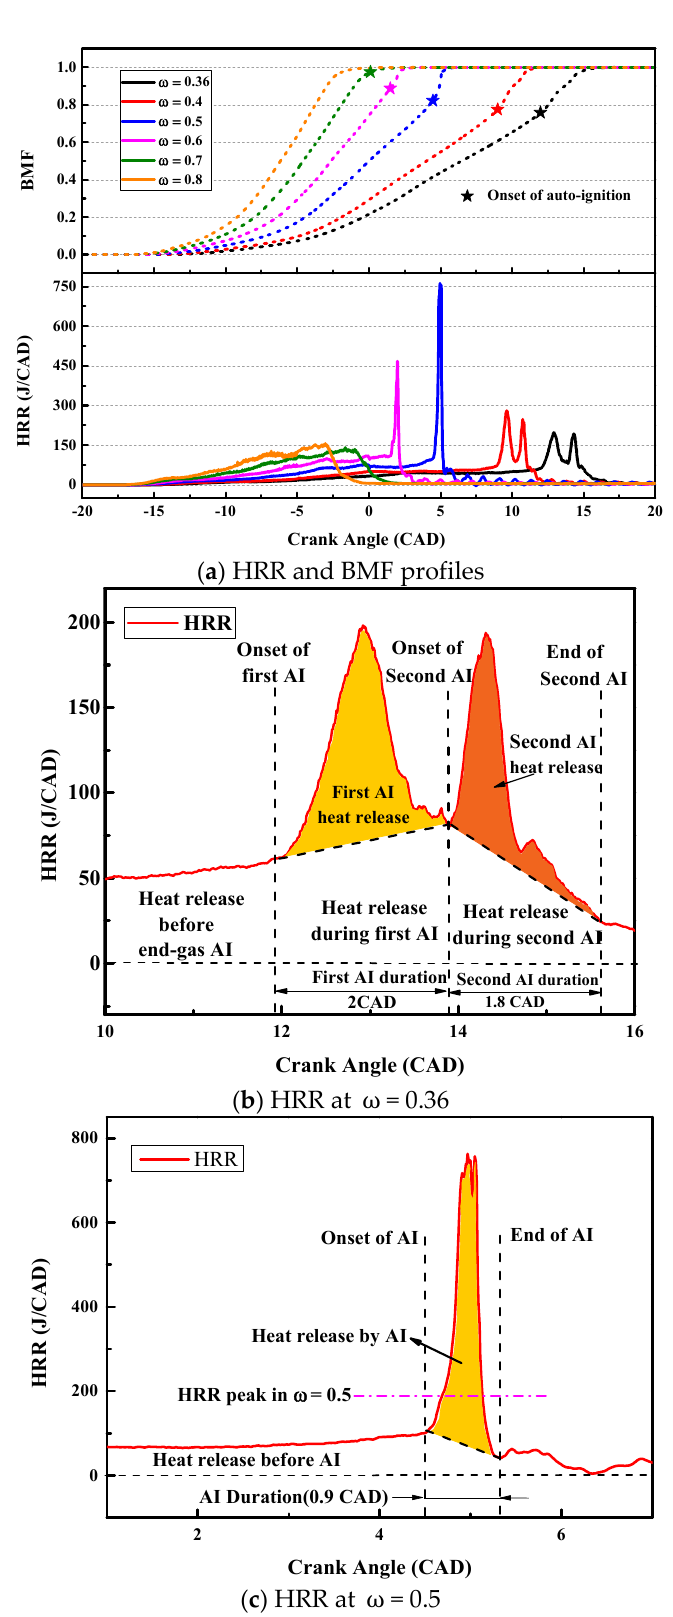
Figure 8. ( a ) HRR and BMF profiles with different flame velocities and amplified HRR profile of ( b ) ω = 0.36 and ( c ) ω = 0.5.